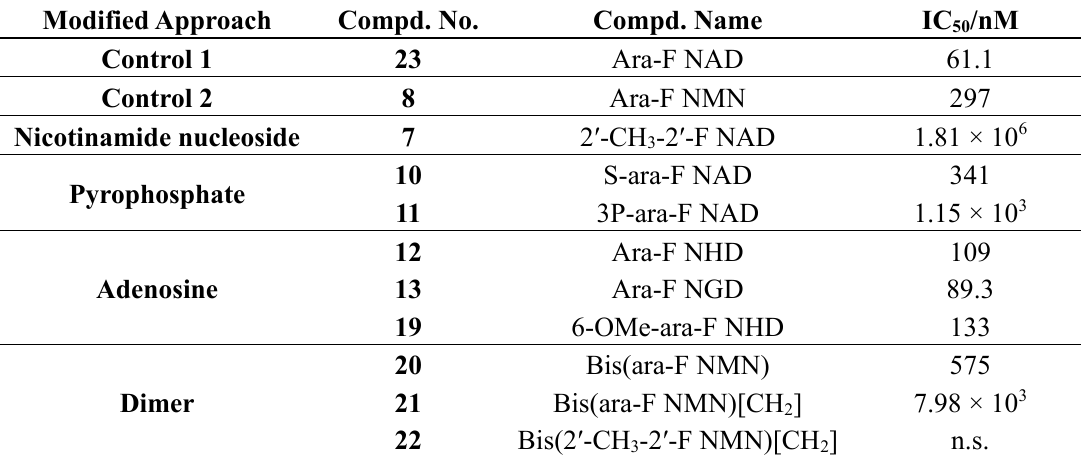
Table 1. Summary of NAD analogues and their inhibitory activities of CD38 NADase. n.s. = no significant inhibitory effect was